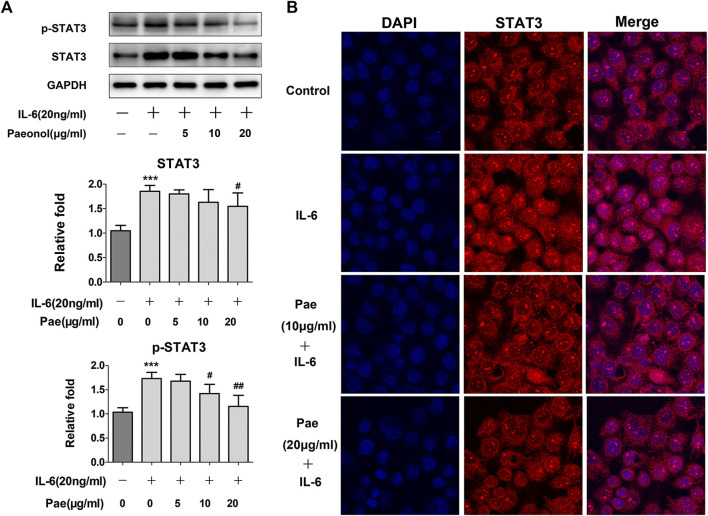
Paeonol disrupts STAT3 signaling in A549 cells stimulated with IL-6. A549 cells were treated with paeonol at indicated concentrations and/or IL-6 (20 ng/ml) for 24 h. (A) Western blot analyses of p-STAT3 and total STAT3 with quantification. GAPDH was used as an invariant control for equal loading and representative blots were from three independent experiments (n = 3). Significance: ***p < 0.001 vs. control, #p < 0.05 vs. IL-6, ##p < 0.01 vs. IL-6. (B) Immunofluorescence double staining for determining STAT3 nuclear translocation. Original magnification ×400. Representative images are shown from triplicate experiments.